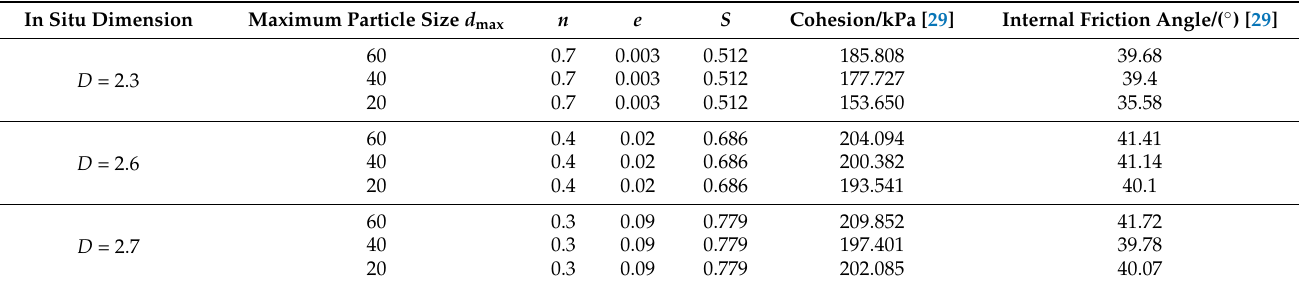
Table 4. Fitting results of test data of rockfill material soil.